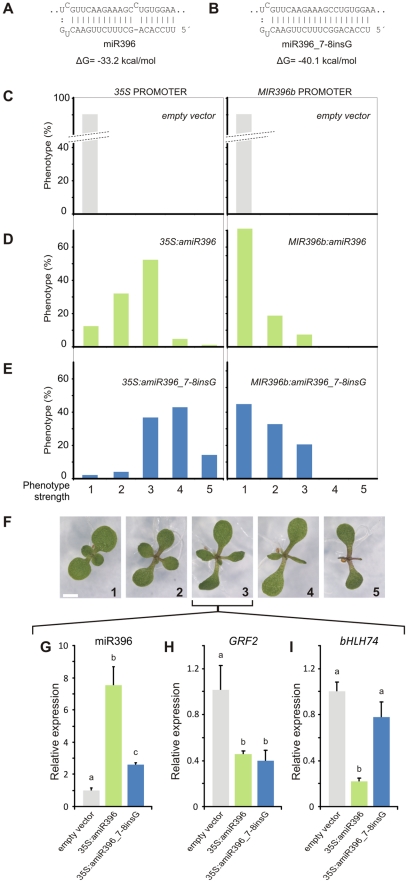
The monocot-version of miR396 is hyperactive towards the GRFs.(A,B) Scheme showing the interaction between Arabidopsis GRF2 and either miR396a (A) or rice miR396e,f (miR396_7-8insG) (B), which is a monocot-specific variant. (C–E) Phenotype frequency in independent transgenic plants (T1) expressing an empty vector (C), Arabidopsis miR396a (D), rice miR396e,f (miR396_7-8insG) (E). MiR396a and miR396_7-8insG were expressed from the viral 35S (left) and MIR396b (right) promoters. At least 100 independent transgenic plants were scored for each vector. (F) Phenotypes of transgenic plants (12-day old seedlings) harboring the different vectors. Phenotypes were classified according to the area reduction in leaves #1 and #2. Scale Bar: 2 mm. (G) to (I) miR396, GRF2 and bHLH74 levels in control plants (transformed with an empty vector, gray) and transgenic plants overexpressing Arabidopsis miR396a (light green) or miR396_7-8insG (blue) displaying an intermediate phenotype. RNA levels were determined by RT-qPCR using pools of 20 independent T1 seedlings. Data shown are mean ± SEM of 3 biological replicates. Bars marked with different letters are significantly different as determined by ANOVA and Duncan's multiple range test (P<0.05).